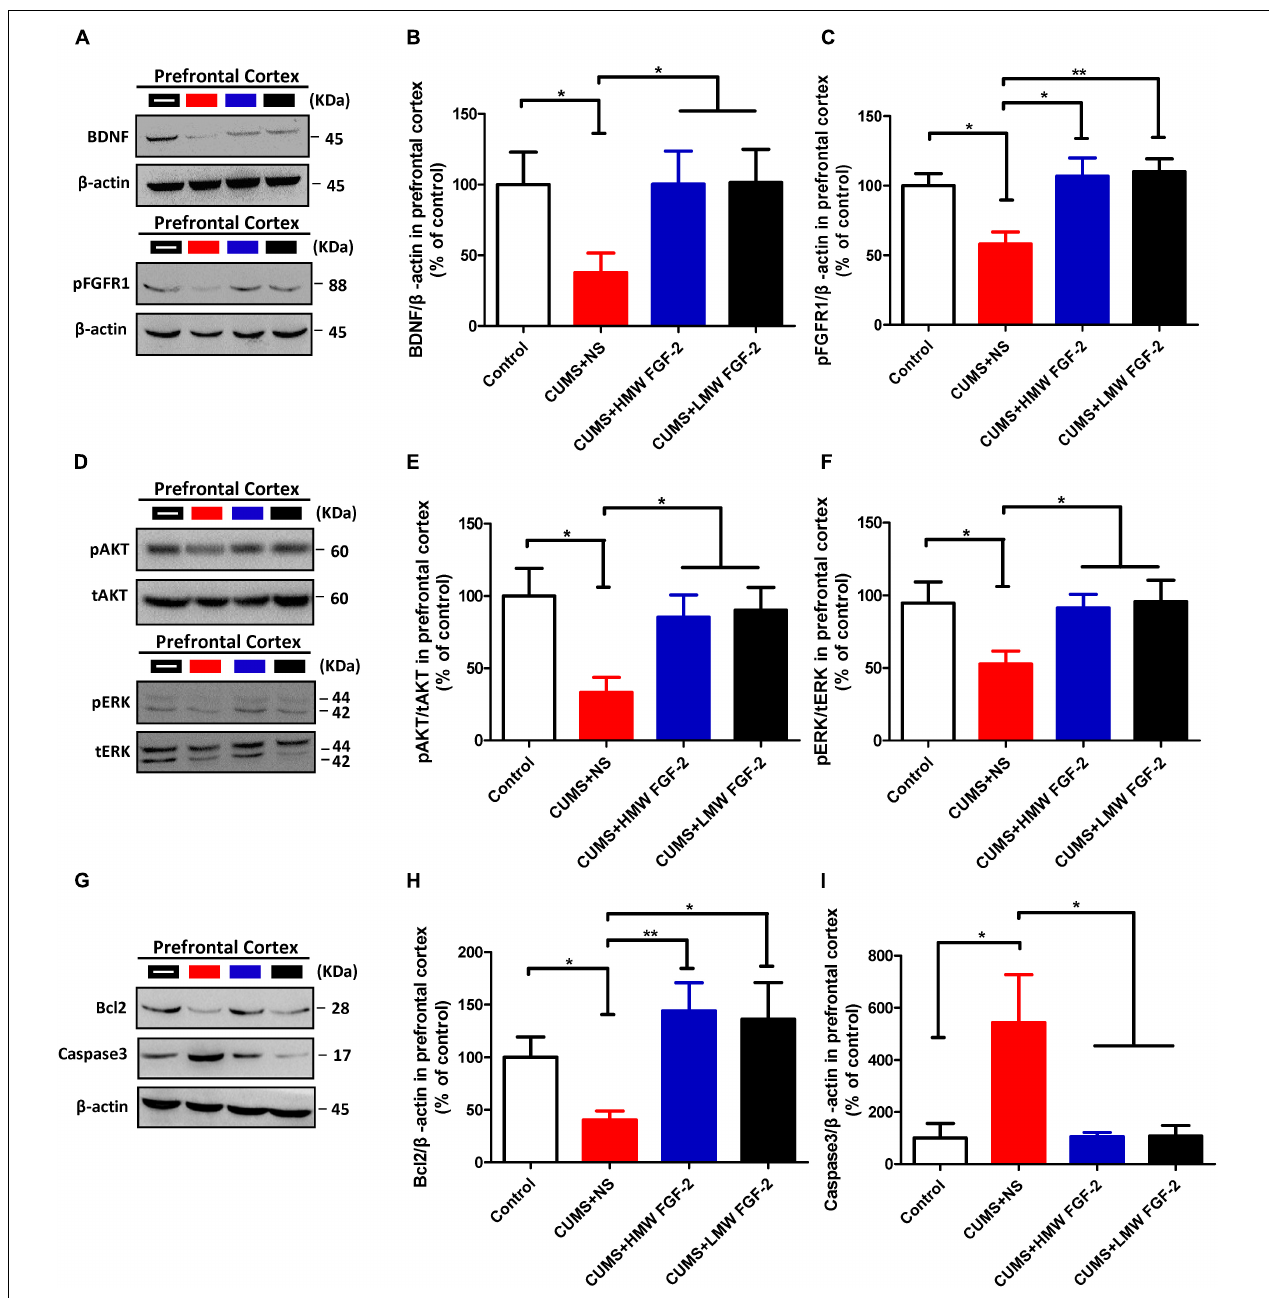
FIGURE 6 | FGF-2 upregulates BDNF protein expression and activates the ERK and AKT signaling pathways by acting on FGFR1 in the prefrontal cortices of CUMS-induced mice. Representative immunoblots of BDNF and pFGFR1 (A) , p-AKT/t-AKT and p-ERK/t-ERK (D) , and Bcl-2 and caspase-3 (G) detected by Western blotting in tissues from the prefrontal cortex. The remaining panels depict the quantification of immunoblotting bands of BDNF (B) , p-FGFR1 (C) , p-AKT (E) , p-ERK (F) , Bcl-2 (H), and caspase-3 (I) . Panels (B,C,E,F,H,I) were analyzed by one-way ANOVA with Tukey’s post hoc test, n = 5, ∗ p < 0.05, ∗∗ p < 0.01, and ∗∗∗ p <